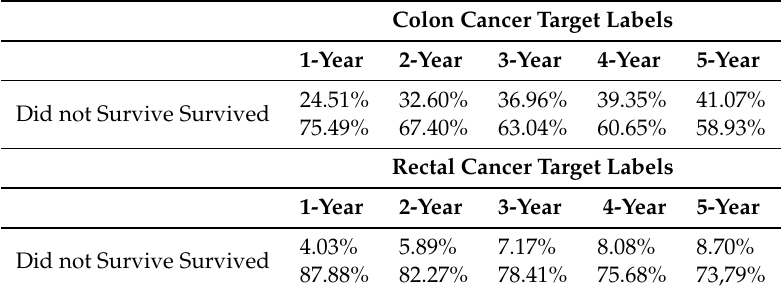
Table 3. Class distribution for each colon and rectal cancer sub-datasets according to target label.